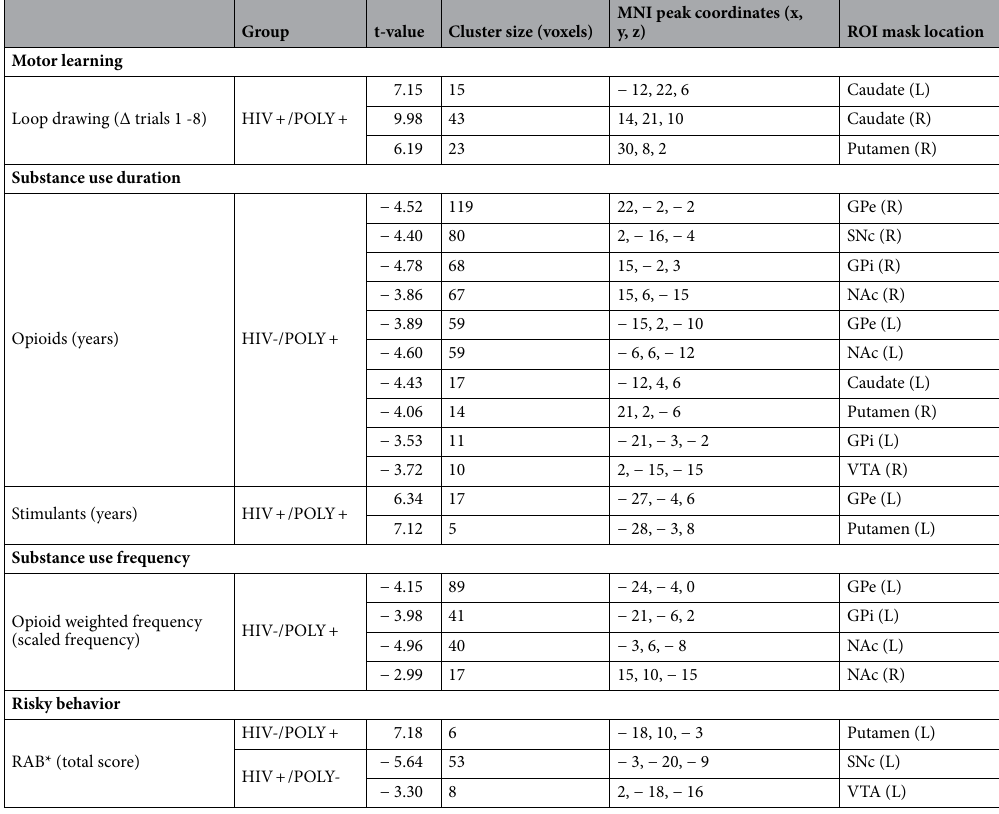
Controls (HIV-/POLY−) vs. clinical groups t-value Cluster size (voxels) MNI peak coordinates (x, y, z)